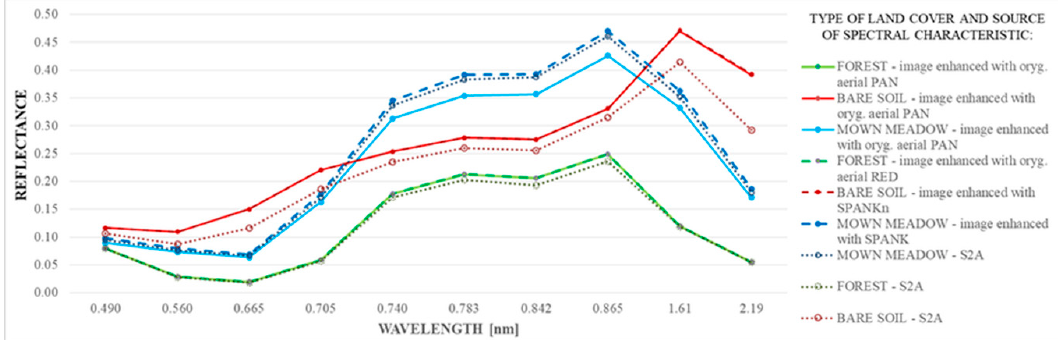
Figure 7. Spectral reflectance characteristics of the studied samples.